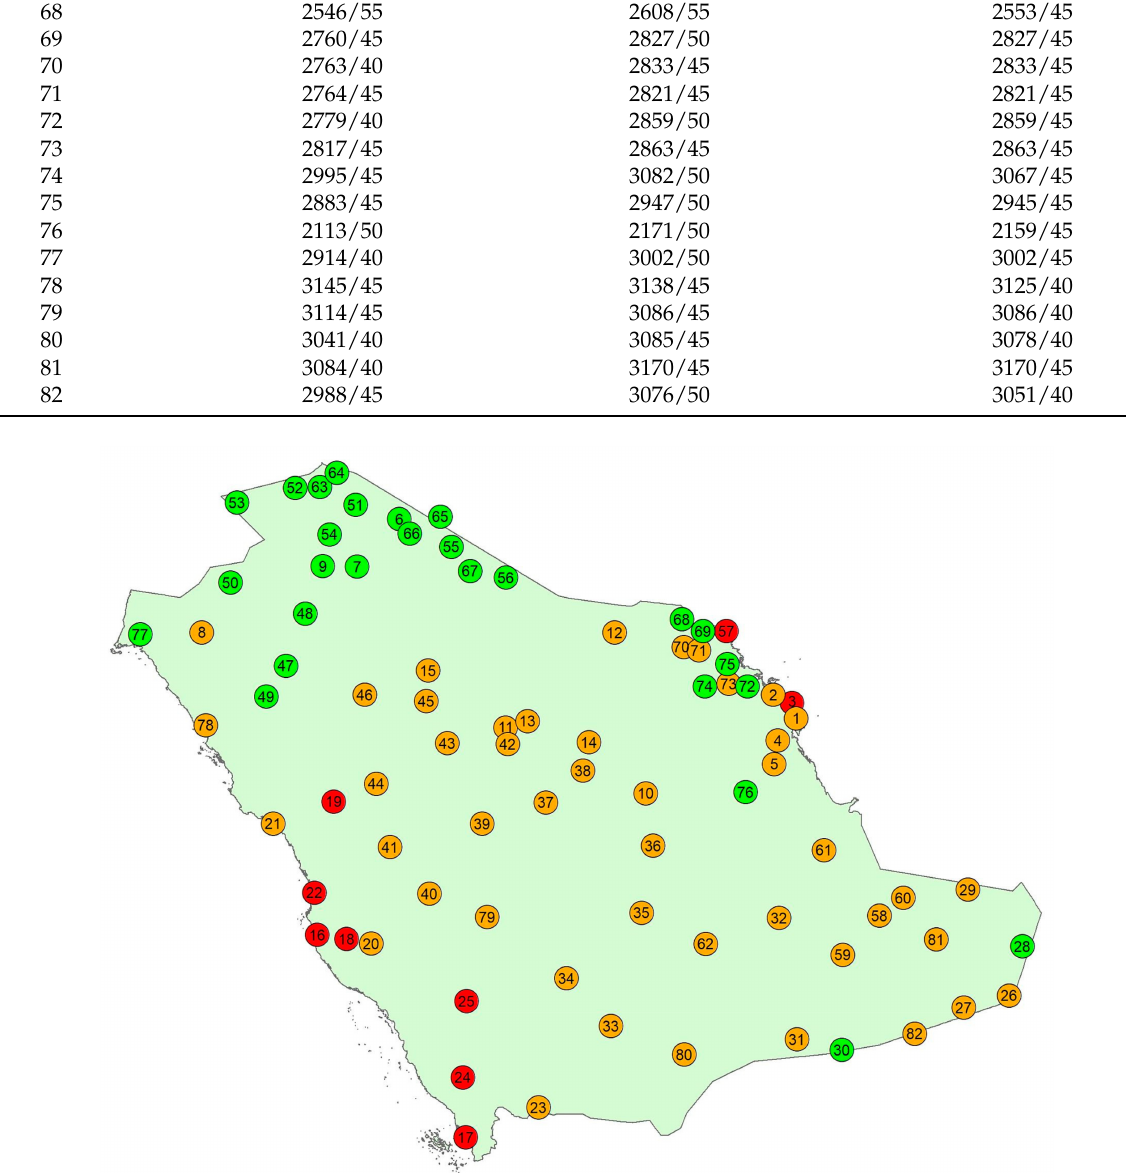
Figure 2. Distribution of the 82 selected sites in Saudi Arabia for maximum H g,t,opt. β / ρ g . The numbers in the circles refer to those in column 1 of Table 1. The red circles correspond to sites with opt. β = 40 ◦ , the orange with opt. β = 45 ◦ , and the green ones with opt. β = 50 ◦